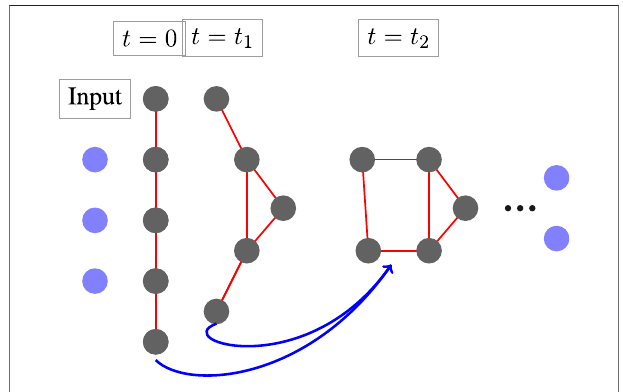
FIGURE 1 | The architecture of MimNet with graph convolution layers. An embedding layer transforms the input into a latent space which then propagatesthroughaGCNlayerfedwiththeoutputsoftwopreviouslayers.A graph that represents the protein structure iscomputed after each layer. The fi nal layer is then projected back to obtain residue